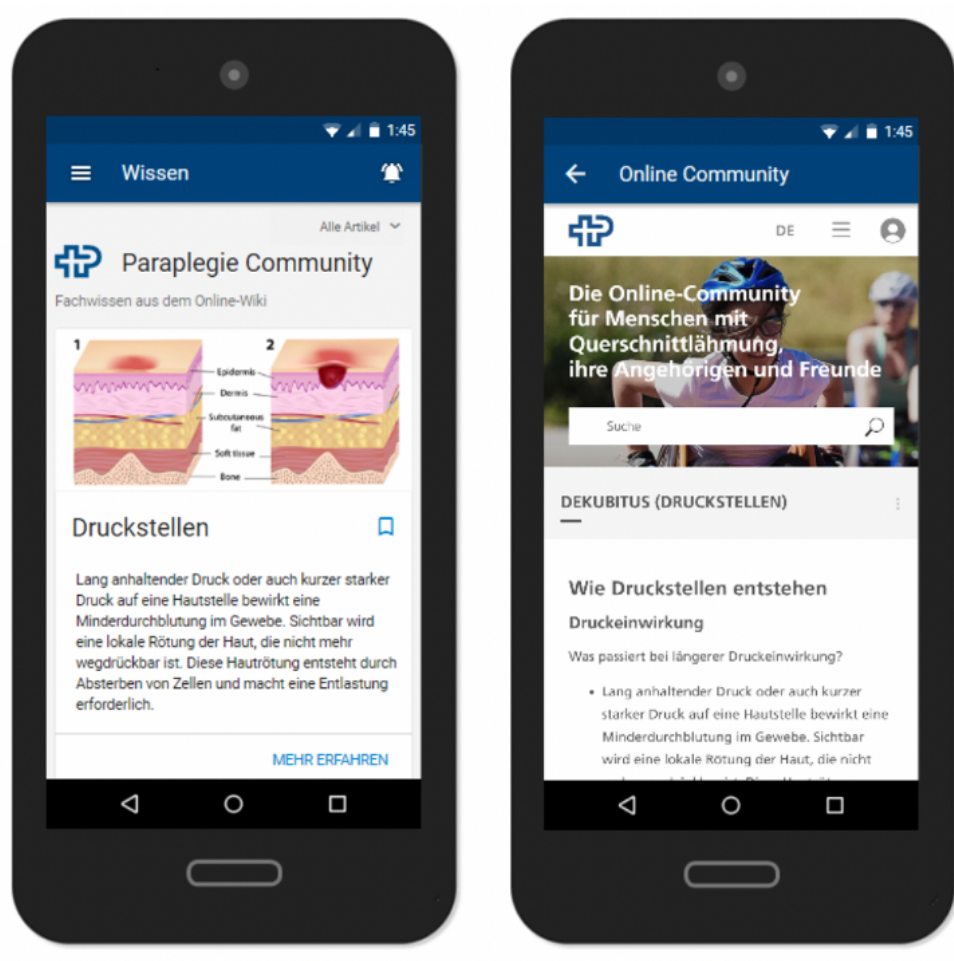
Figure 6. Knowledge